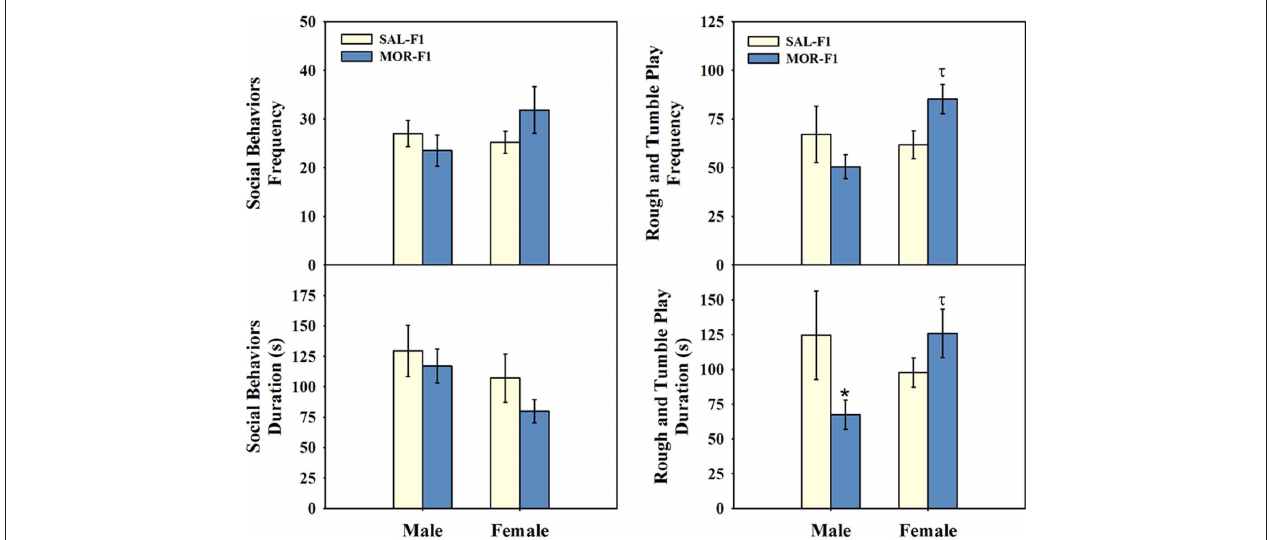
Figure 4 | Mean ( ± SeM) frequency and duration (seconds) of either general social behaviors (left panels) or rough and tumble play (right panels) in the offspring of females exposed to either morphine (MOr-F1) or saline (SAL-F1) during adolescence. * p < 0.05 as compared SAL-F1 males, τ p < 0.05 as compared to MOR-F1 males. N = 10 SAL-F1 male; N = 10 SAL-F1 female pairs and N = 12 MOR-F1 male; N = 12 MOR-F1 female